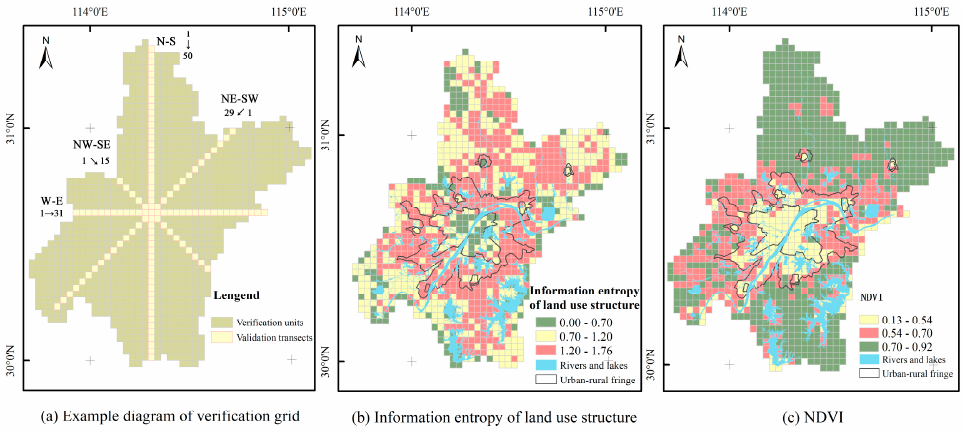
Figure 8. Verification grid and its measured value.